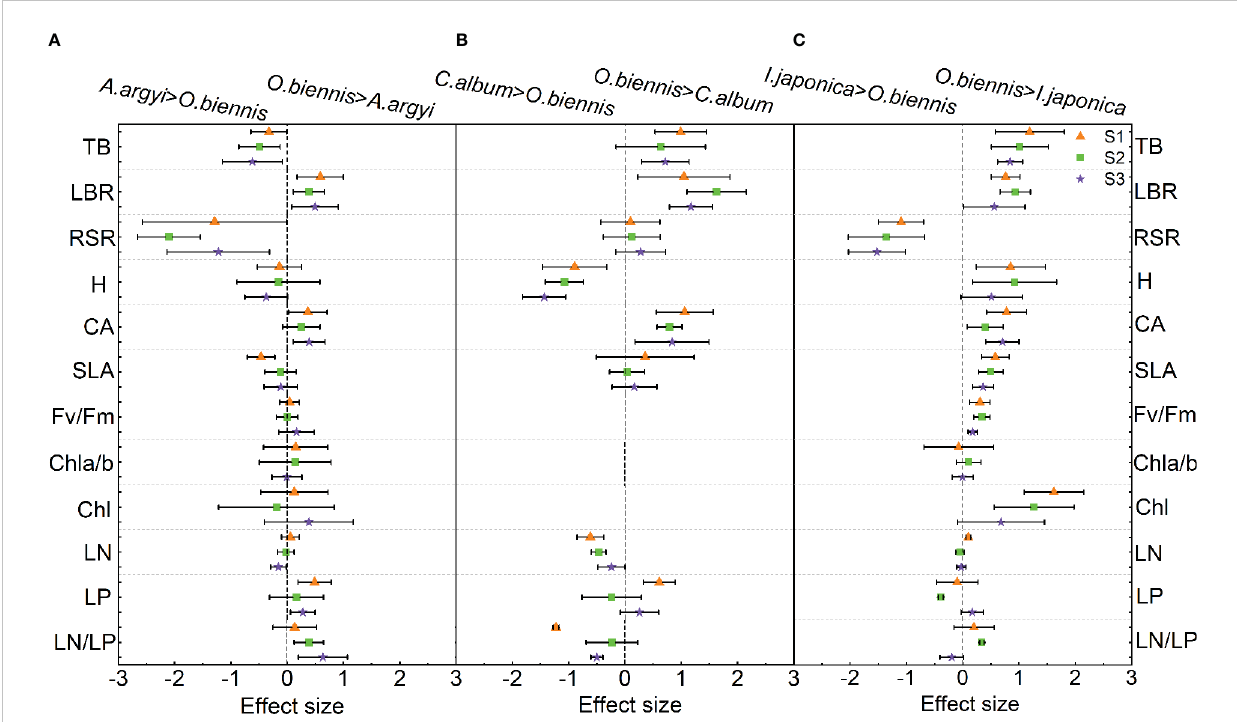
FIGURE 2 Relative difference values of different functional traits between invasive ( Oenothera biennis ) and native species ( Artemisia argyi , Chenopodium album , and Inula japonica ) under three salinity treatments in the mixture. The orange triangle illustrates the S1 treatment (control), the green square illustrates the S2 treatment (low salt treatment), and the purple pentagram illustrates the S3 treatment (high salt treatment). The capital letters represent the invasive species O . biennis and their three native species – A. argyi (A) , C. album (B) , and I. japonica (C) under the mixed cultivations. Error bars are 95% con fi dence intervals. Signi fi cant effect sizes are indicated by con fi dence intervals that do not overlap zero. Abbreviations have identical meanings as described in Table